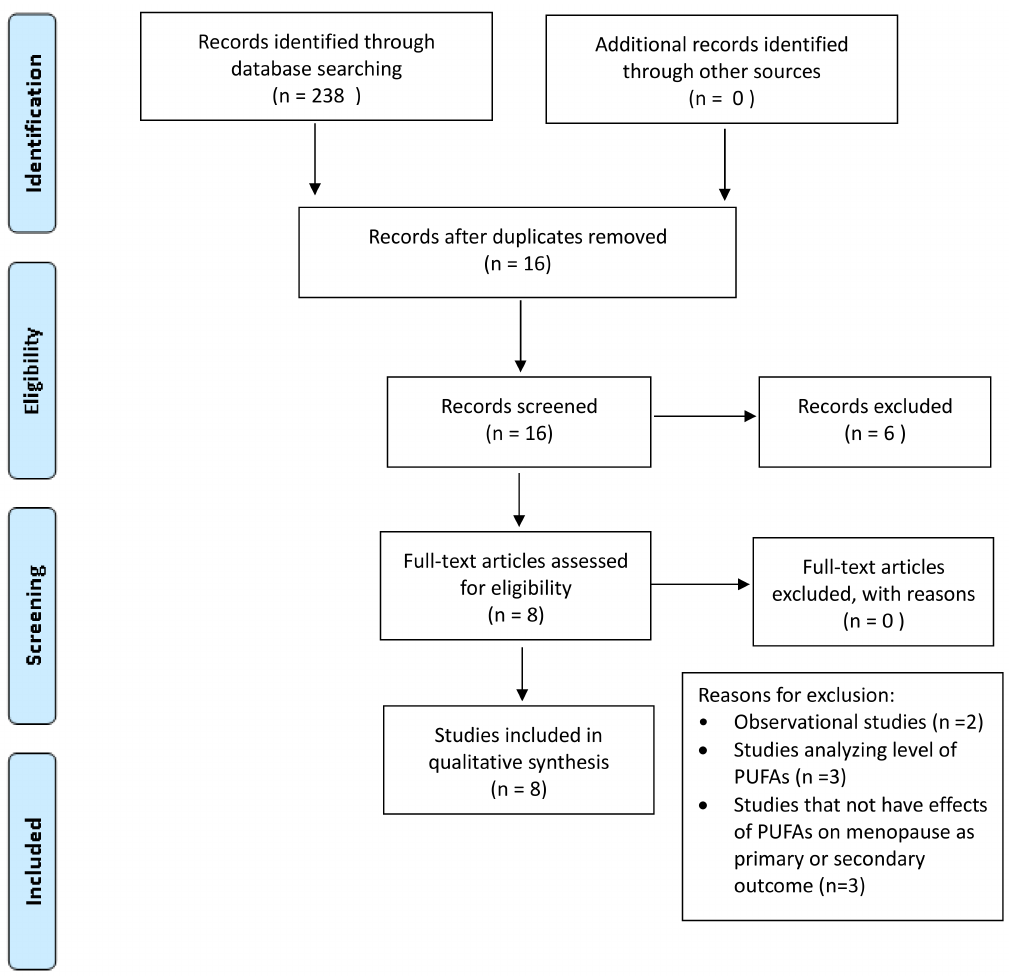
Figure 1. Preferred Reporting Items of Systematic reviews and Meta-Analyses (PRISMA) diagram: n-3 LCPUFAs supplementation in menopausal depressive and cognitive symptoms and hot flashes.